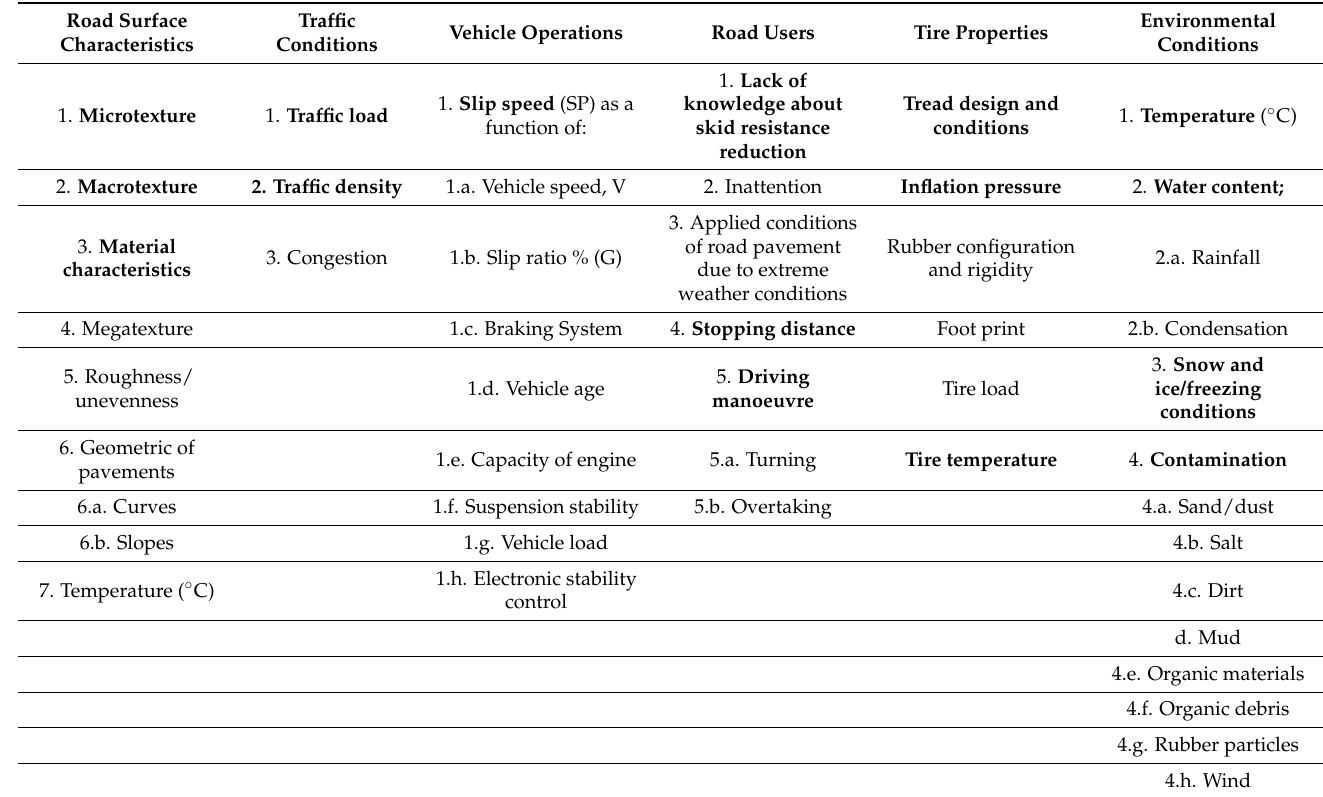
Pavement friction is commonly defined as the force that resists the relative move- ments between a vehicle tire and the surface of the road pavement. Thus, skid resistance is generated due to the rolling or sliding of vehicle tires on the pavement surface [5,20]. Various factors can, directly and indirectly, influence the changes occurring in the skid resistance of the surface pavement. Table 1 shows a critical summary list of the main fac- tors that affect the skid resistance of surface pavements. Table 1. Factors affecting the pavement surface skid resistance (modified from [12,20]), grouped into 6 categories. Road Surface